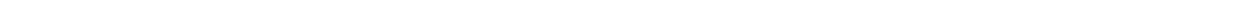
Fig. 5 Depletion of injury-activated glia in the granulation tissue impairs wound healing. a Representative macroscopic illustration of wound healing in Ctrl and Sox10 cKO animals at D0 and D7. b Longitudinal macroscopic quanti fi cation of individual wound areas at D2, D4, D7, and D9 in Ctrl and Sox10 cKO animals in relation to their respective initial size at D0. Data show a signi fi cant delay in wound closure at D7 upon Sox10 cKO. c H&E-stained sections of Ctrl and Sox10 cKO D7 wounds used for morphometric analysis of percentage of wound closure (length of newly formed epithelium (NFE)/length of NFE + length of gap between edges of wound epithelium (black dotted line) × 100), area of HPE, wound contraction (distance between wound border HFs (blue dotted line)), and re-epithelialisation (length of NFE). Analysis of D7 wound sections for the percentage of d wound closure, e area of HPE, f wound width, g re-epithelialisation. h Immunolabelling of myo fi broblasts with α -SMA (green) in Ctrl and Sox10 cKO skin wound sections at D7. Dashed line delimits granulation tissue. i Quanti fi cation of the percentage of α -SMA + area of the granulation tissue at D7 shows a reduction of the area occupied by myo fi broblasts upon Sox10 cKO. Western blot quanti fi cation for j myo fi broblast marker α -SMA and k Periostin (Postn) of D7 whole-wound protein extracts from Ctrl and Sox10 cKO animals. l Immunolabelling of α -SMA (green) and pSMAD2 (red) in Ctrl and Sox10 cKO skin wound sections at D7. Boxed regions in the dermis are shown in the insets at higher magni fi cation as pSMAD2 single channel and merged with α -SMA channel. m Quanti fi cation of highly pSMAD2 + cells per α -SMA + area of the granulation tissue at D7. Data are represented as mean ± SEM of N = 10, n = 39 (Ctrl), N = 13, n = 49 ( Sox10